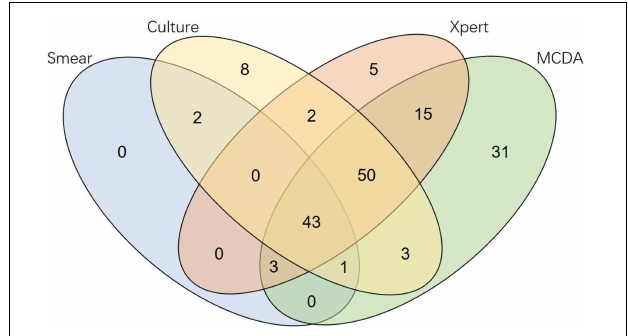
FIGURE 2 | Venn diagram of different diagnostic methods.